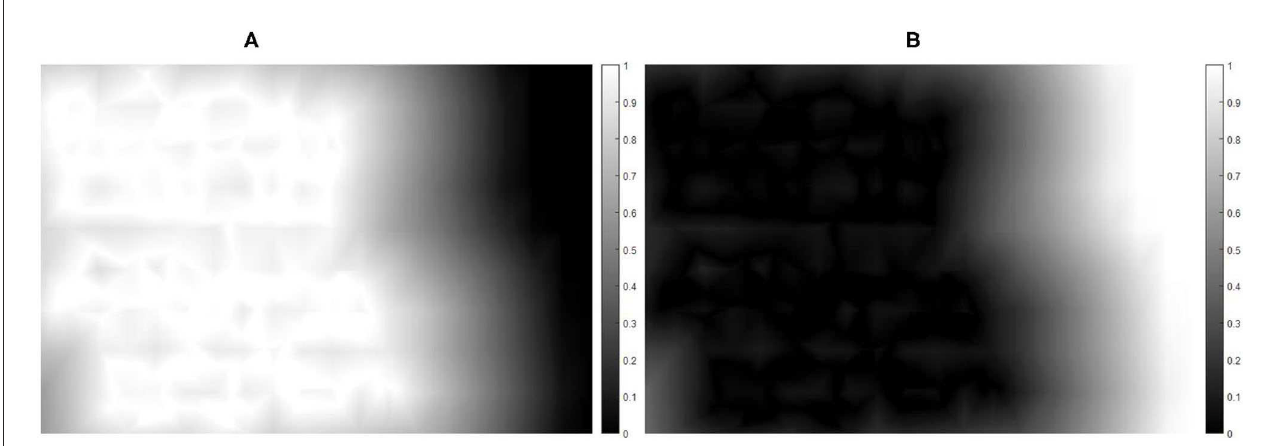
FIGURE4 Weight map of the target image. (A) Weight map of content-preserving warps and (B) weight map of APAP warps. The color denotes the weight value, which is between 0 and 1.